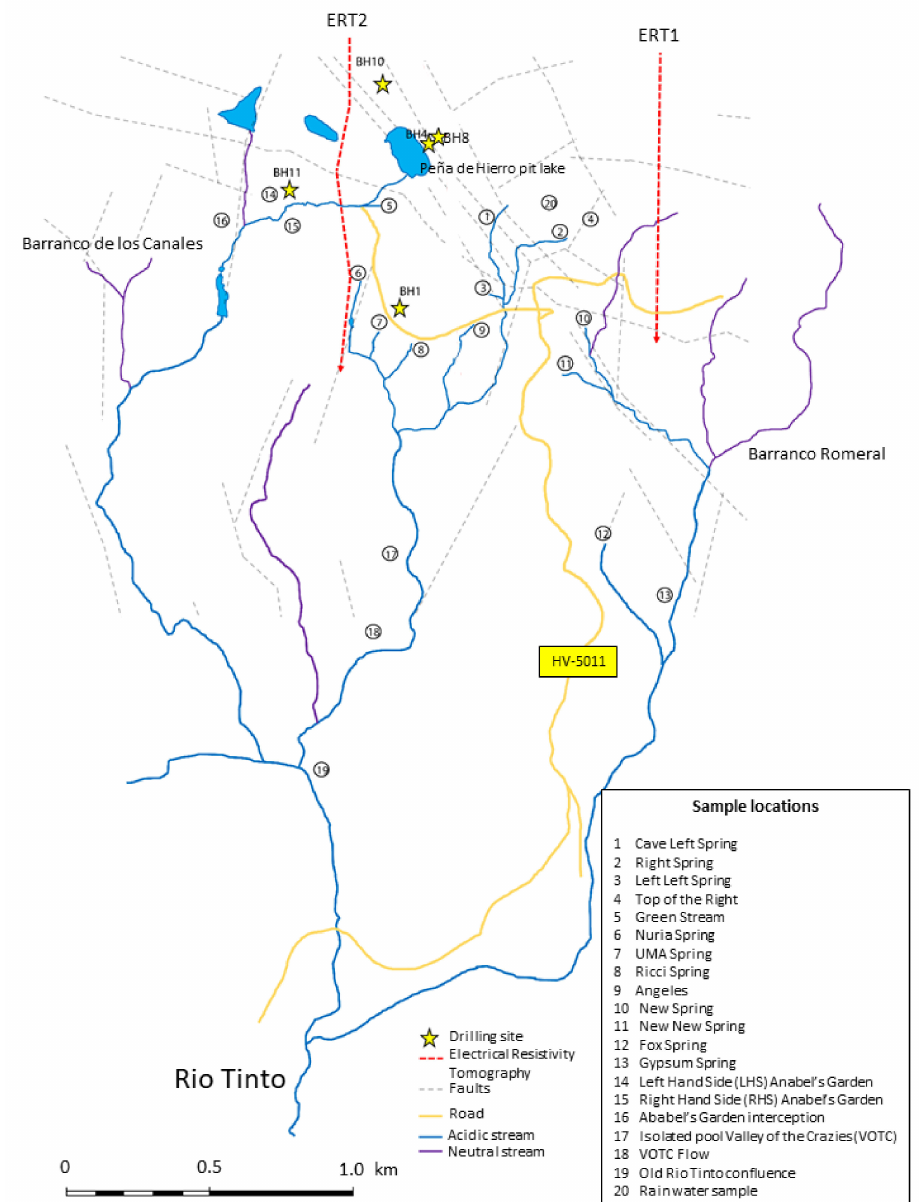
Figure 2. Peña de Hierro study area showing the sampling locations and the trails of the ERT (Electrical Resistivity Tomography) profiles 1 and 2 (see Supplementary Figure S2) that were used to unlock the underground structure in the study